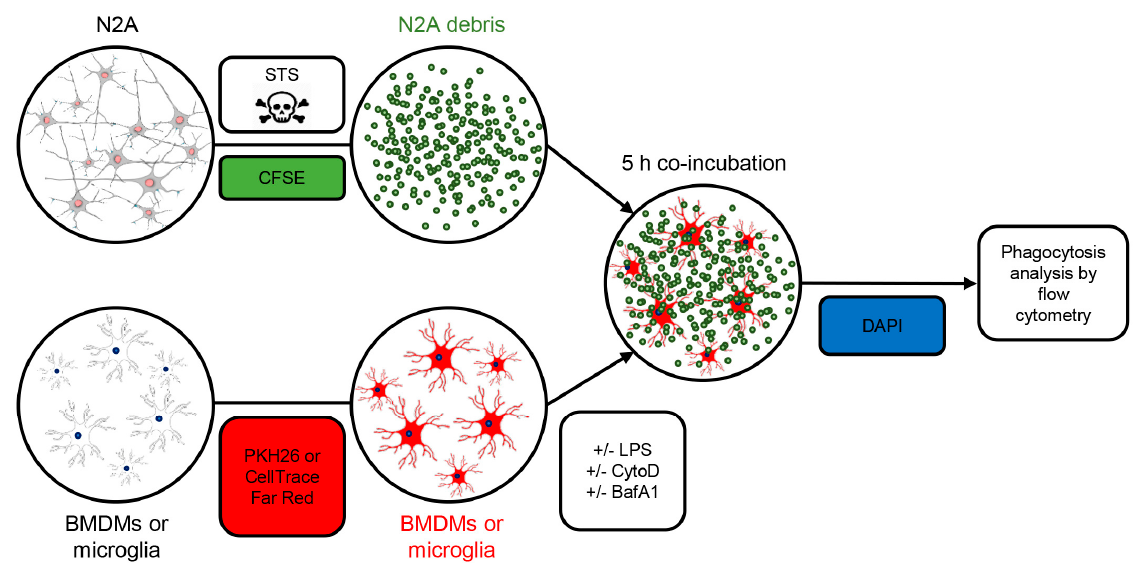
Figure 1. Setup for apoptotic cell phagocytosis assay. The Neuro2A (N2A) cells were